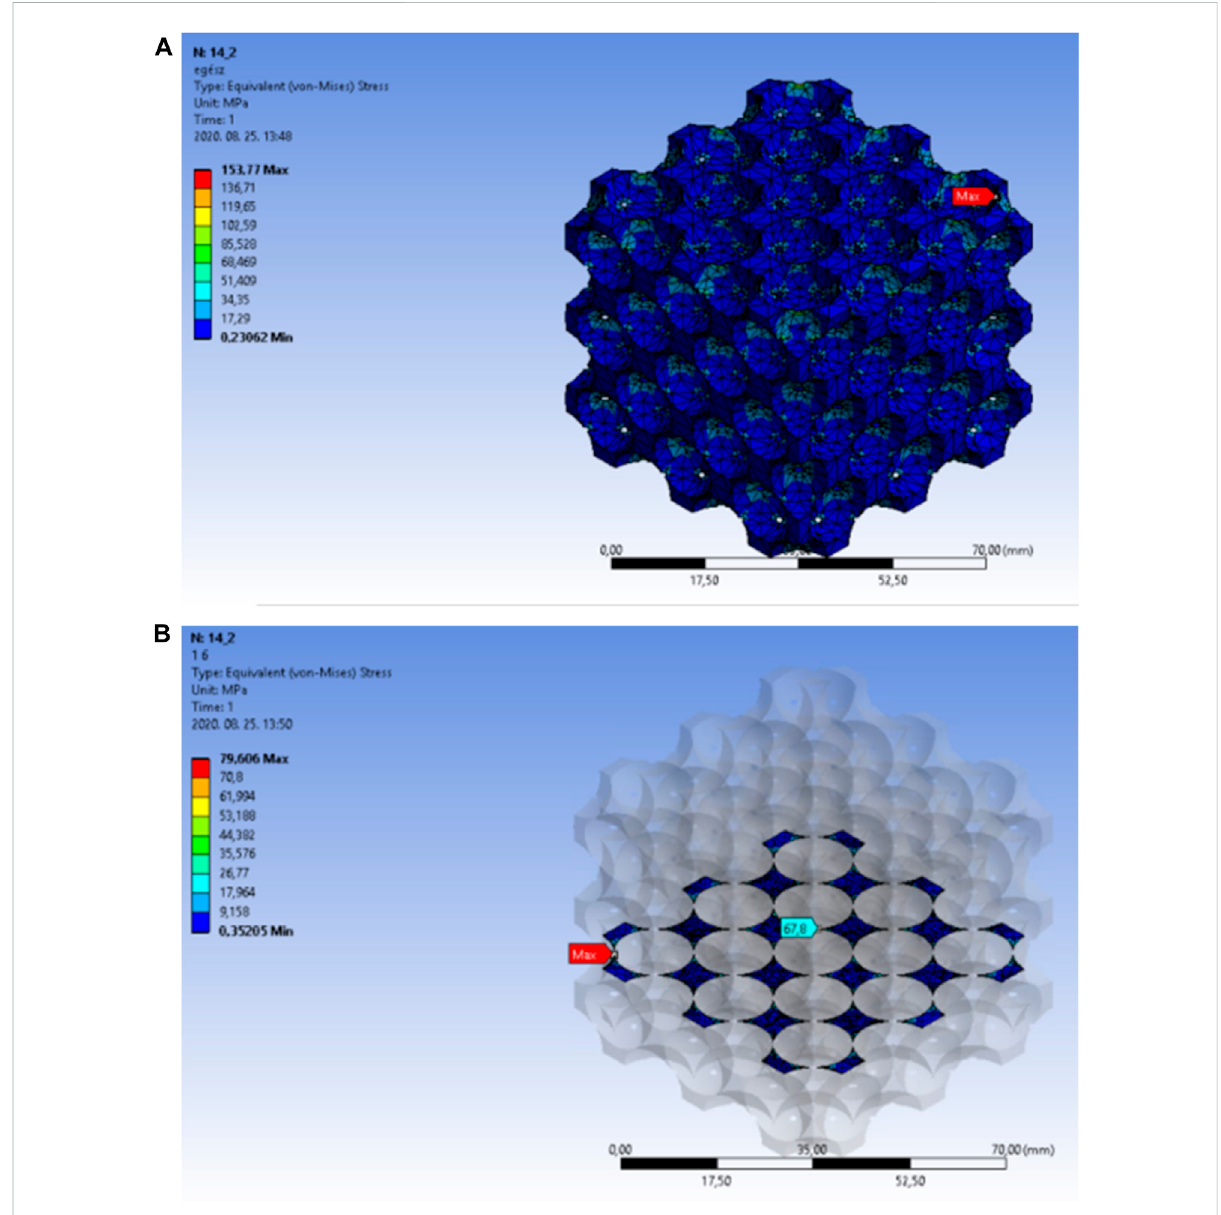
FIGURE 9 (A) Equivalent stress distributionin the overall lattice of face-centredcubic structure at aporosity of 74.94%. (B) Equivalentstress distribution in the internal area of the face-centred cubic cell structure at a porosity of